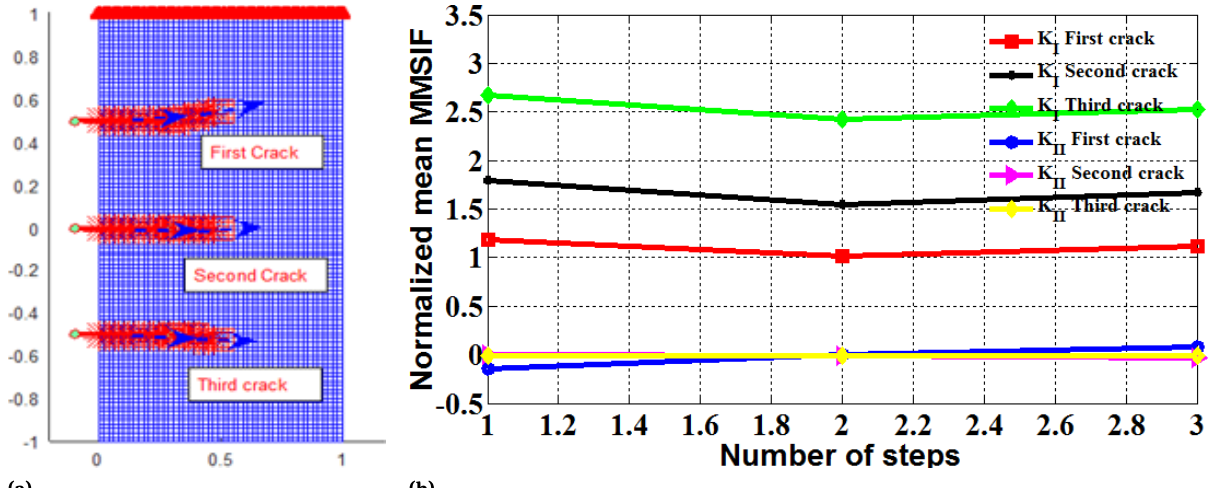
Figure 7: (a) Crack propagation path for triple edge crack plate under tensile loading and (b) Normalized